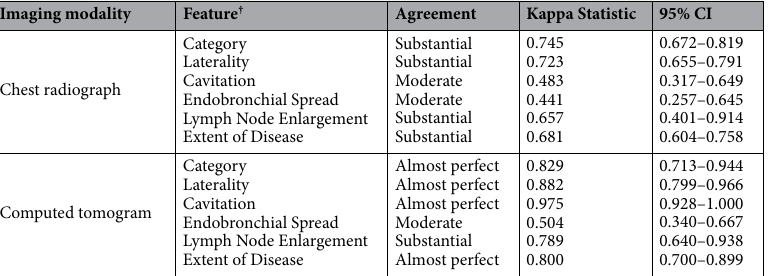
Table 2. Expert inter-reader variability of subclinical PTB chest radiograph and computed tomogram interpretation The kappa statistic for the chest radiograph features have been previously reported (see reference #6). † See text for definition of chest radiographic and computed tomographic features; see reference #13 and the online Supplement 3 for definition of extent of